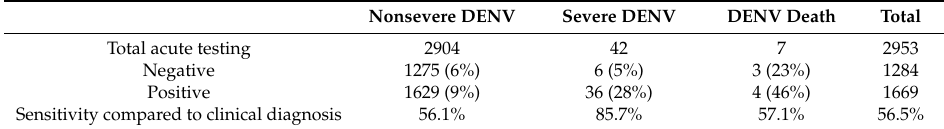
Table 1. Results for acute dengue virus (DENV) testing by clinical